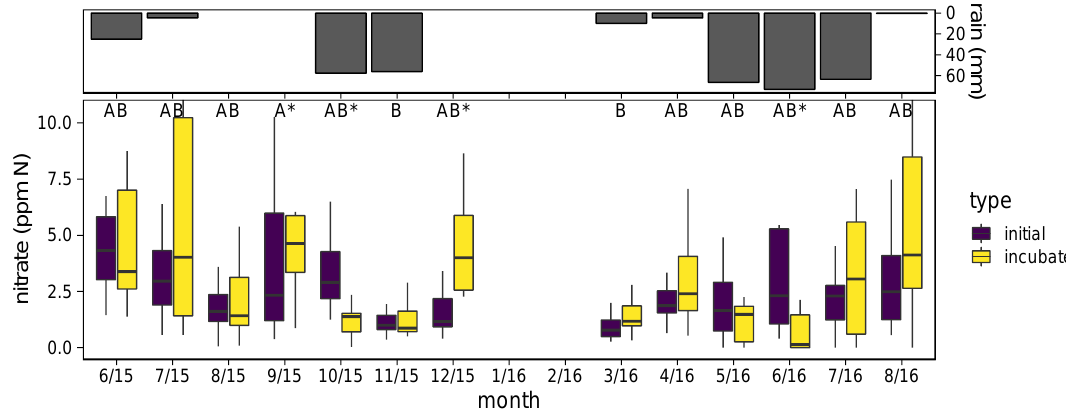
Figure 7. Soil extractable nitrate (parts per million nitrogen (ppm N) g − 1 dry soil) in initial and one-week incubations at seven bioswales sampled at two depths monthly ( n = 423) from June, 2015 to August, omitting two winter months. The letters above represent statistically significant differences among periods and * signifies periods where initial and incubated samples were statistically different. The bars at the top denote rain amounts during the one-week incubation periods.